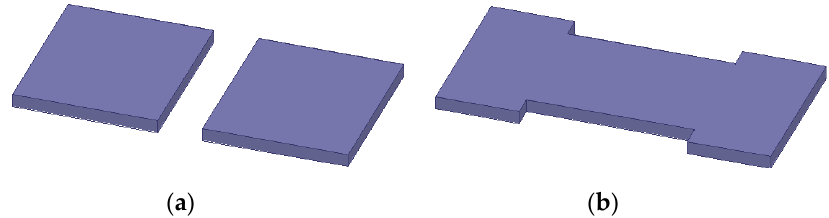
Figure 25. Optimized core in a DD coupler: ( a ) Primary core; ( b ) Secondary core.